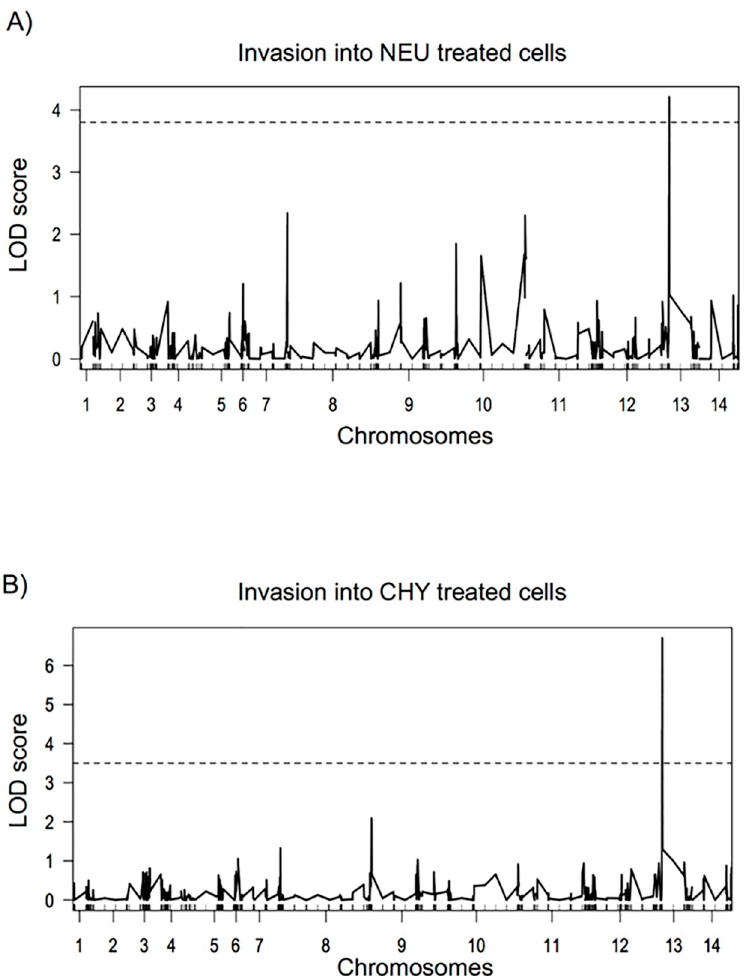
Fig 2. Genome-wide scan to detect quantitative trait loci (QTL) associated with erythrocyte invasion in the 7G8xGB4 cross. Logarithm of odds (LOD) score results for (A) NEU and (B) CHY invasion phenotypes, correlating with 5,433 SNPs across the genome generated by whole genome sequencing data. The dashed line represents the significant threshold (95%) based on 1000 permutations of the data.